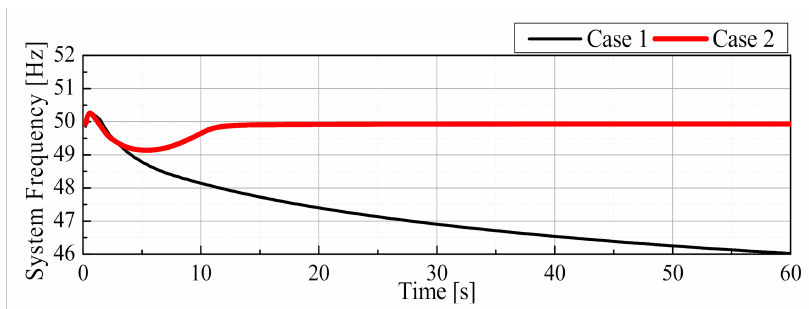
Figure 17. Battery output (Generating Operation).